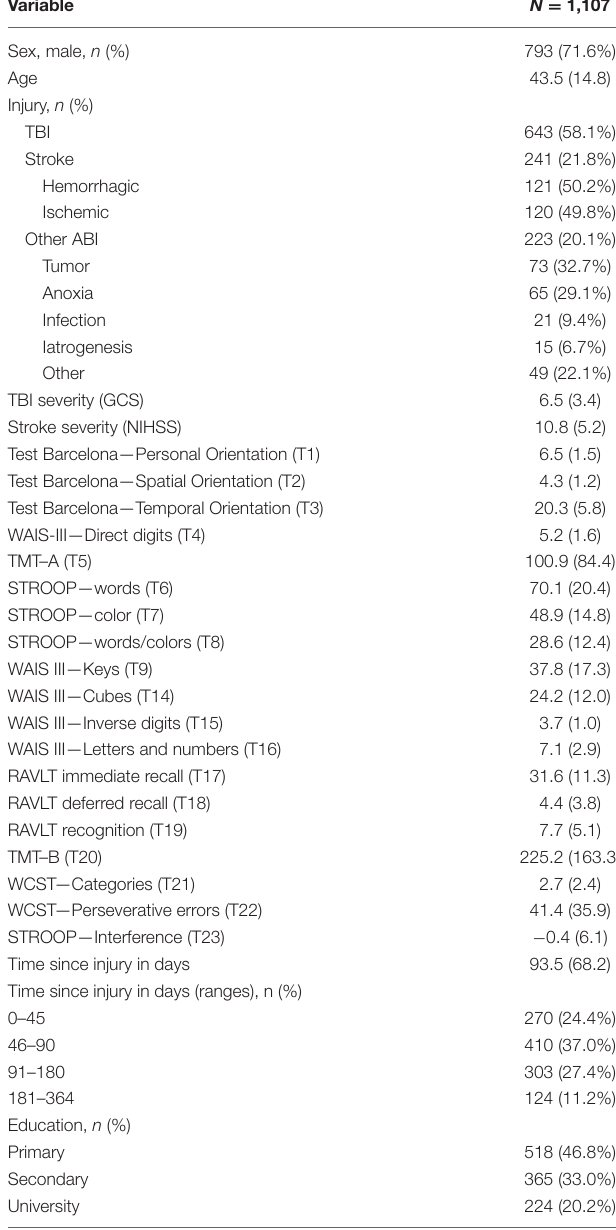
TABLE 2 | Demographics and clinical characteristics at